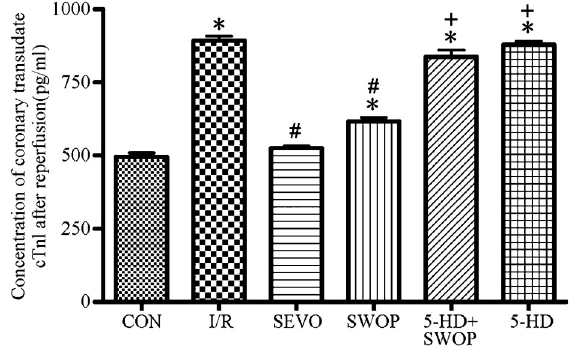
Figure 2. Concentration of coronary transudate cTnI after 2 h of reperfusion. cTnI: cardiac troponin I; CON: control; I/R: ischemia/ reperfusion; SEVO: sevoflurane; SWOP: second window of protection; 5-HD: 5-hydroxydecanoate. *P , 0.05 vs CON group; # P , 0.05 vs I/R group; + P , 0.05 vs SWOP group (one-way